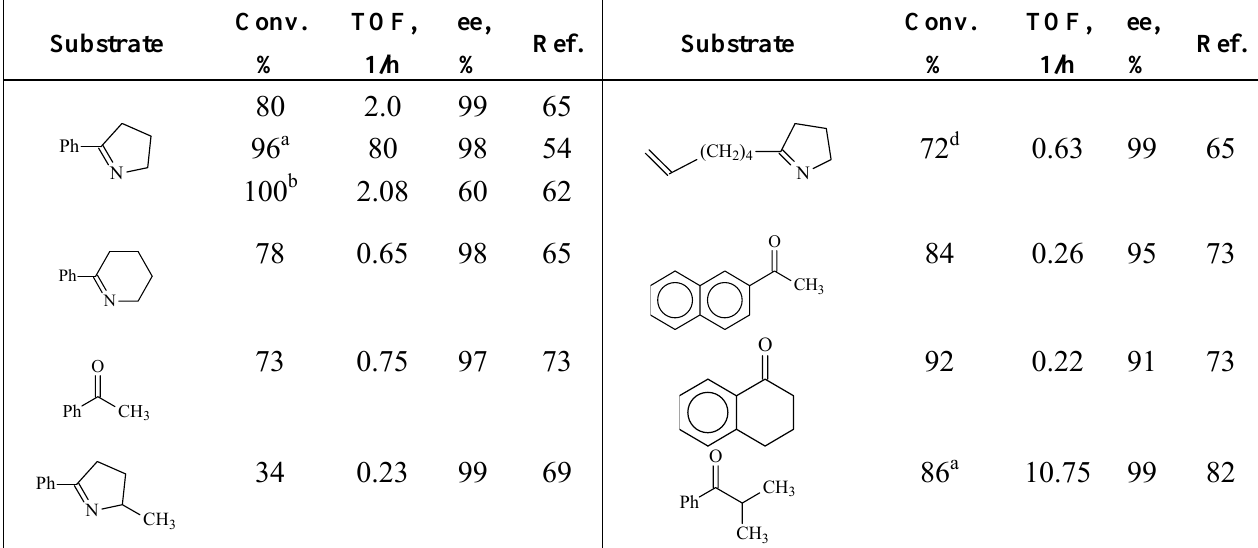
Table 1 . Some examples of enantioselective reductions with chiral